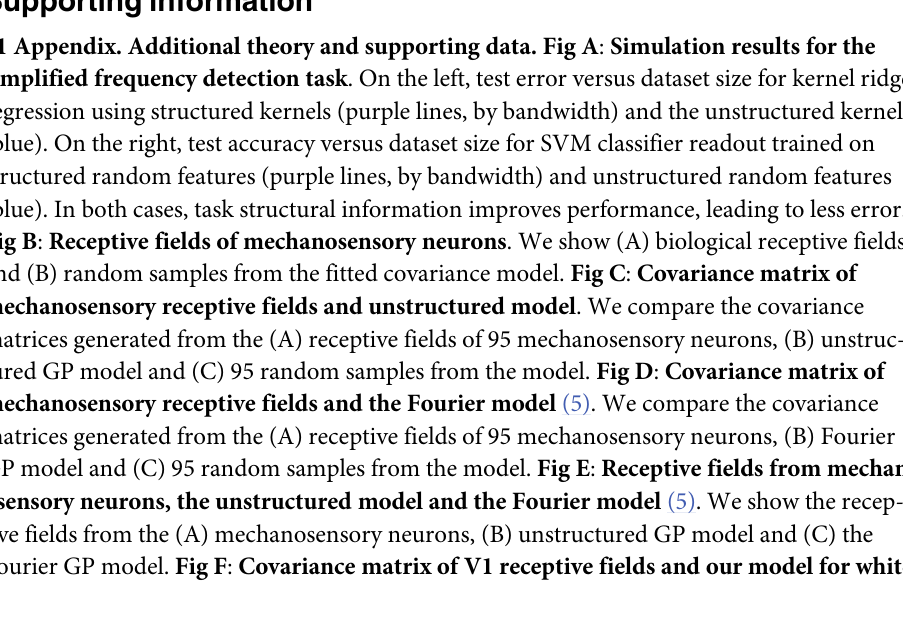
Fig B : Receptive fields of mechanosensory neurons . We show (A) biological receptive fields and (B) random samples from the fitted covariance model. Fig C : Covariance matrix of mechanosensory receptive fields and unstructured model . We compare the covariance matrices generated from the (A) receptive fields of 95 mechanosensory neurons, (B) unstruc- tured GP model and (C) 95 random samples from the model. Fig D : Covariance matrix of mechanosensory receptive fields and the Fourier model (5). We compare the covariance matrices generated from the (A) receptive fields of 95 mechanosensory neurons, (B) Fourier GP model and (C) 95 random samples from the model. Fig E : Receptive fields from mechan- osensory neurons, the unstructured model and the Fourier model (5). We show the recep- tive fields from the (A) mechanosensory neurons, (B) unstructured GP model and (C) the Fourier GP model. Fig F : Covariance matrix of V1 receptive fields and our model for